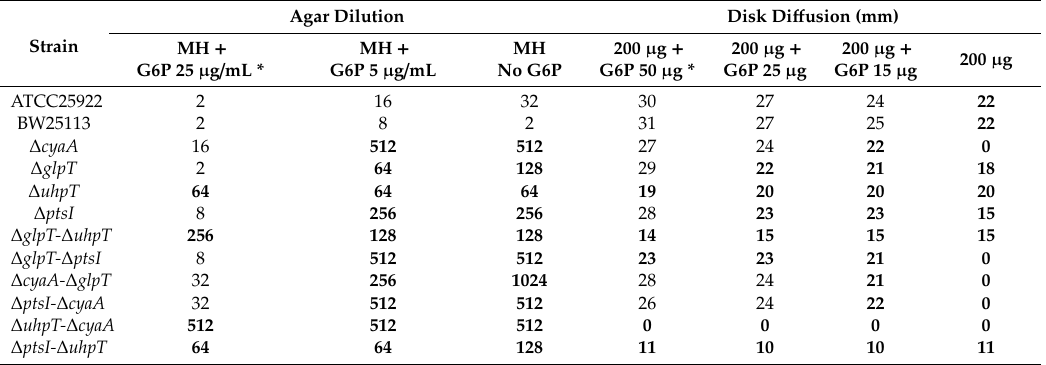
Table 1. Fosfomycin susceptibility results of Escherichia coli strains performed by agar dilution and disk di ff usion